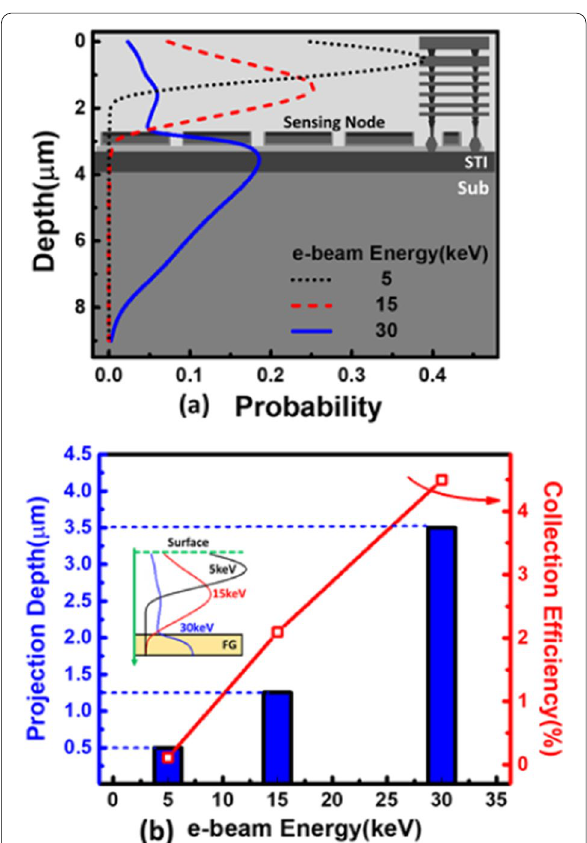
Fig. 3 a Monte Carlo simulation results of the projected trajectory of the injected electron with different accelerating energy, and b the corresponding projection depth and penetration probability onto the on‑wafer detectors